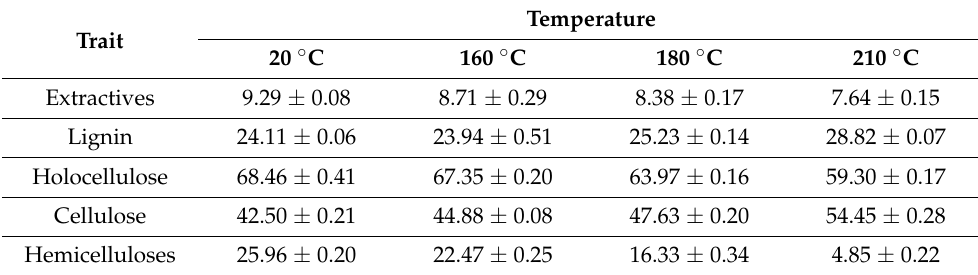
Table 1. Chemical composition of sound and thermally modified black locust wood, oven-dry weight percentages (mean ±